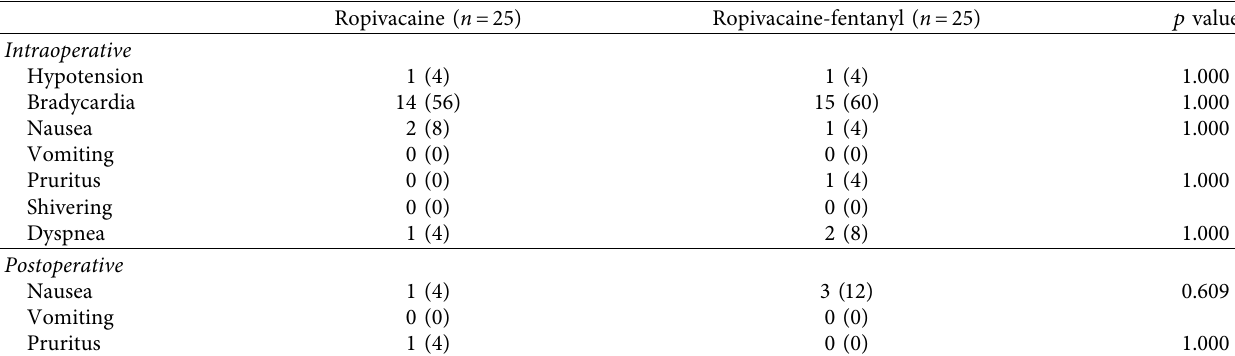
Figure 2: Noninferiority diagram with the difference between Group R and Group RF in the time for two-segment regression of sensory block. Table 3: Intraoperative and postoperative side